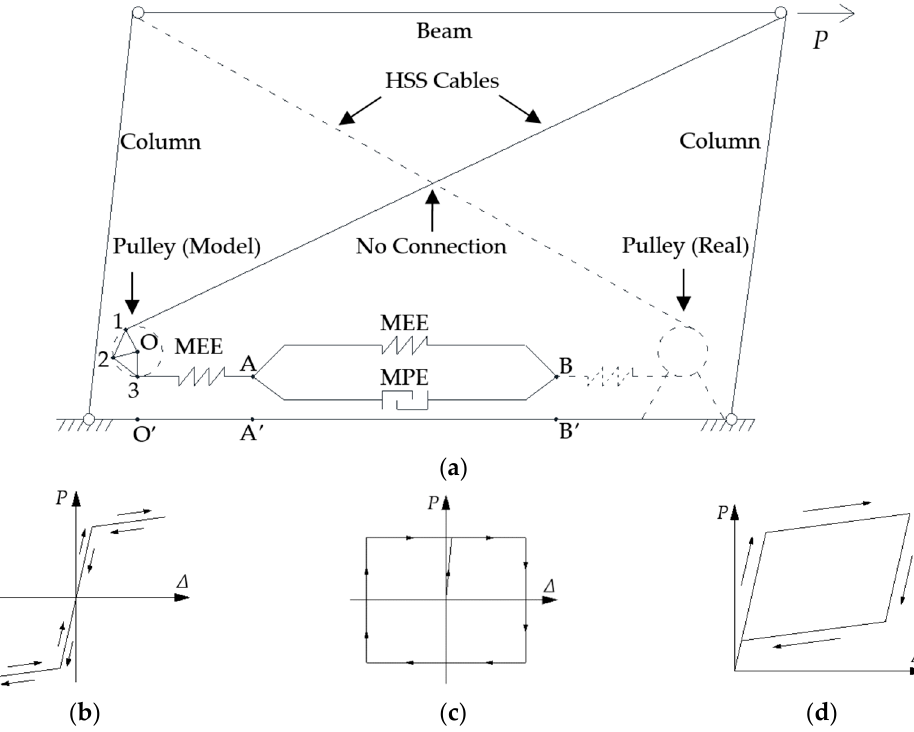
Figure 2. Simulation of the SC-TOB frame (SC-TOBF): ( a ) SC-TOB arrangement; ( b ) multilinear elastic element (MEE) hysteresis; ( c ) multilinear plastic element (MPE) hysteresis; and ( d ) SC-TOB hysteresis.